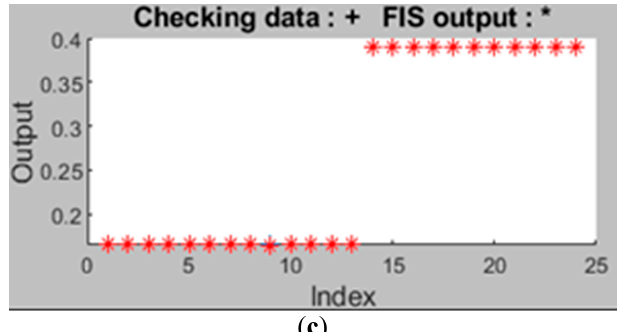
Figure 21. Deviations in FIS output and input data for ( a ) training, ( b ) testing and ( c ) checking.